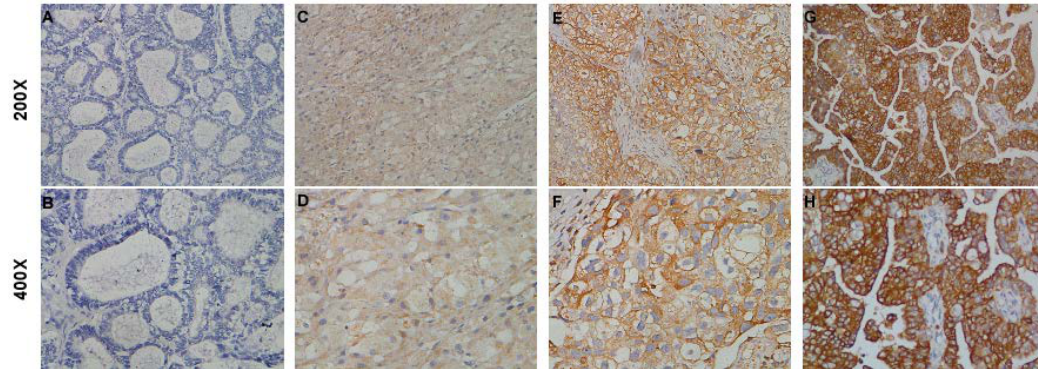
Figure 3. IHC detection of STON2 expression in paraffin-embedded ovarian cancer tissues. Positive STON2 staining was observed mainly in the cytoplasm. ( A , B ) STON2 expression was not detected in adjacent noncancerous tissues; ( C , D ) representative images of weak STON2 staining in ovarian cancer tissues; ( E , F ) representative images of moderate STON2 staining in ovarian cancer tissues; ( G , H ) representative images of strong STON2 staining in ovarian cancer tissues. Table 2. Correlation between STON2 expression and clinicopathological features of epithelial ovarian cancer.